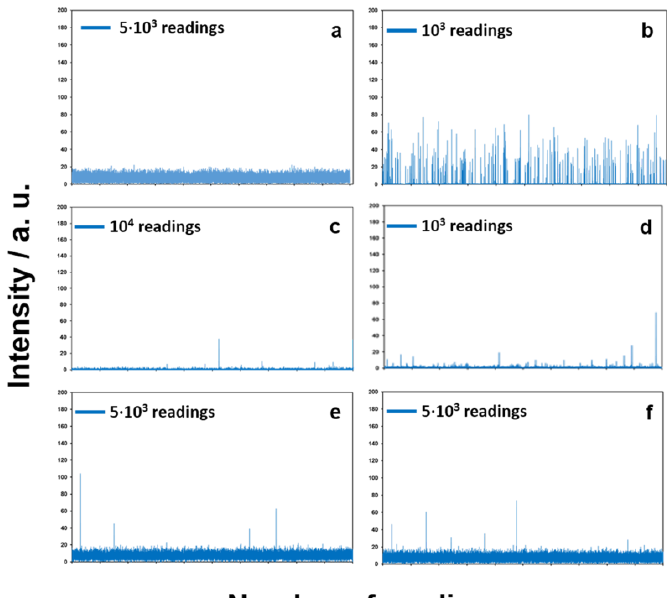
Figure 7. Single particle inductively coupled plasma-mass spectrometry (SP-ICP-MS) spectra of control 1 μg/L Ag + solution ( a ); control AgNP suspension ( b ); solution in contact with untreated leather ( c ); solution in contact with untreated leatherette ( d ); solution in contact with treated leather ( e ); solution in contact with treated leatherette ( f ). Y -axis goes from 0 to 200 a.u. with 20 a.u. increment, in all panels. Scale bars indicate number of data points along X -axis.